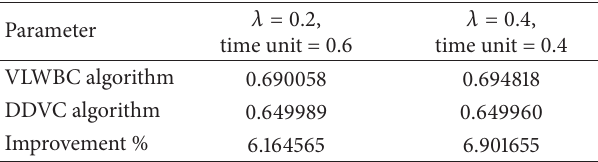
Table 6: VLWBC availability improvement compared to